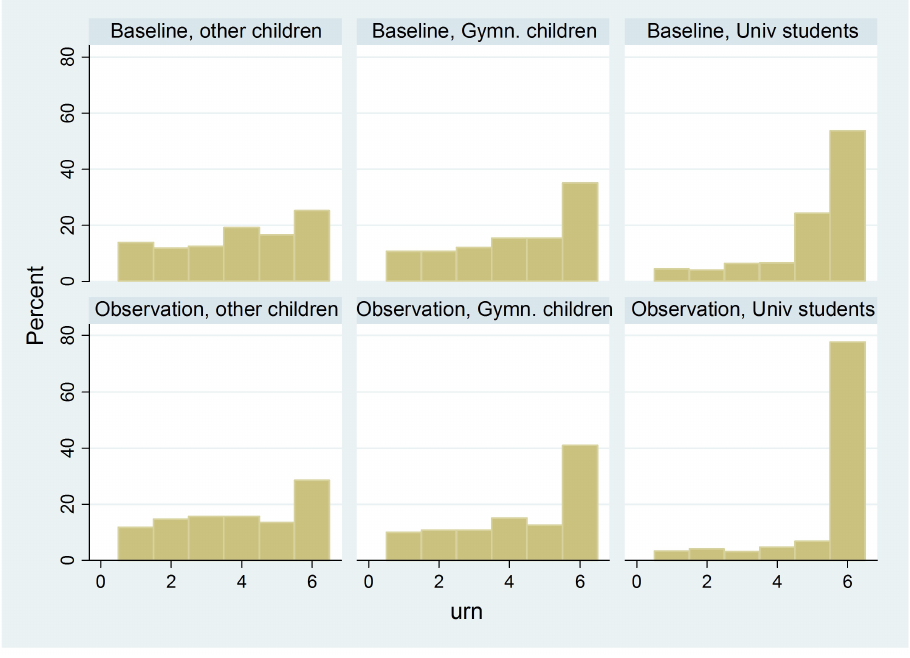
Figure 2. Histograms of urn